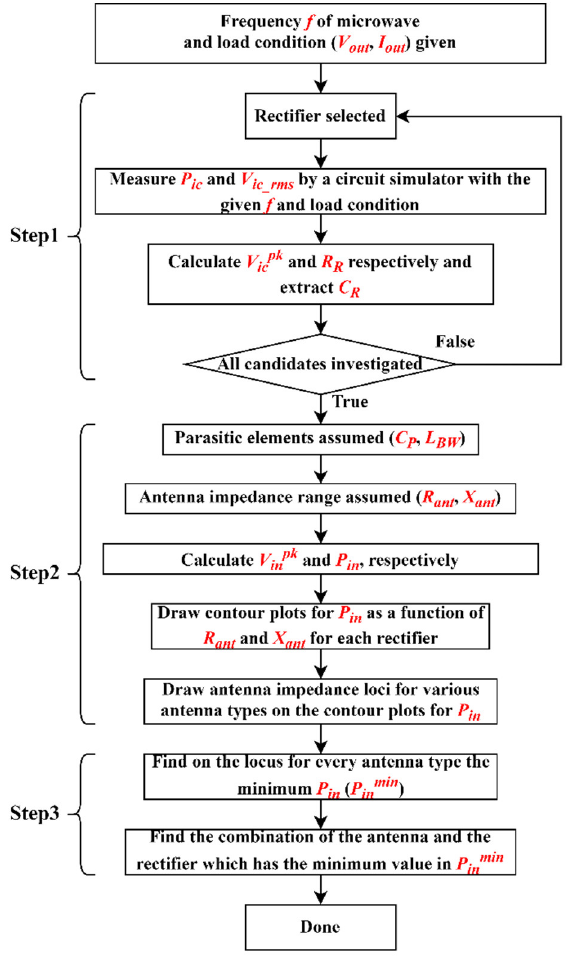
Figure 4. A proposed design flow for simultaneous optimization with a single feedback loop in the backward direction.